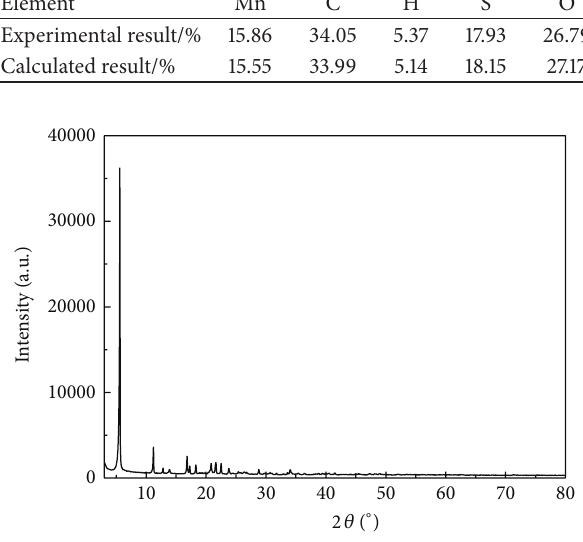
Figure 1: XRD pattern of the complex Mn ( HMHA ) 2